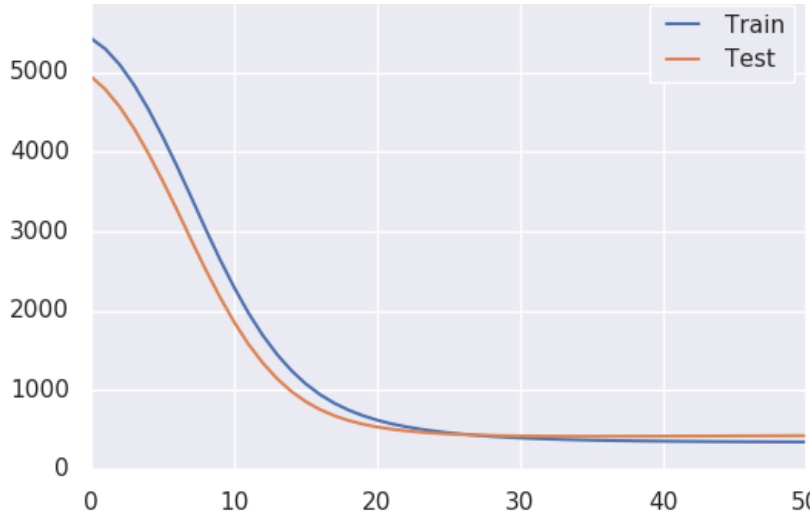
Figure 10. Training and test loss curve of the proposed method.